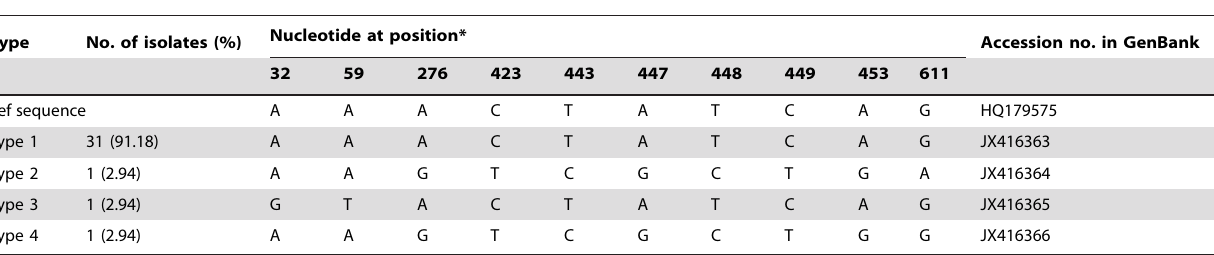
Table 3. Intra-species variations in the SSU rRNA nucleotide sequences of C. bovis .